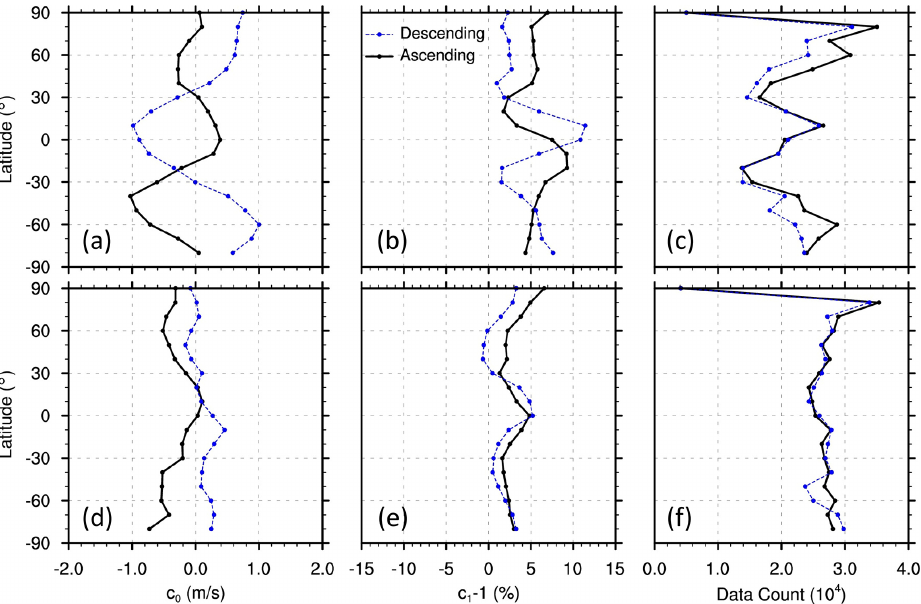
Figure 10. Latitudinal variation in TLS bias coefficients for Mie (a–c) and Rayleigh (d–f) winds. Each point plotted represents a separate TLS analysis for all observations in all vertical layers in a 10 ◦ latitude band for either ascending (black solid) or descending (blue dashed) orbits. The latitude bands are centered every 10 ◦ from 90 ◦ S to 90 ◦ N. The symbols are plotted at the center in each latitude band. The vertical layers are 0–16km for Mie winds and 3–22km for Rayleigh winds.